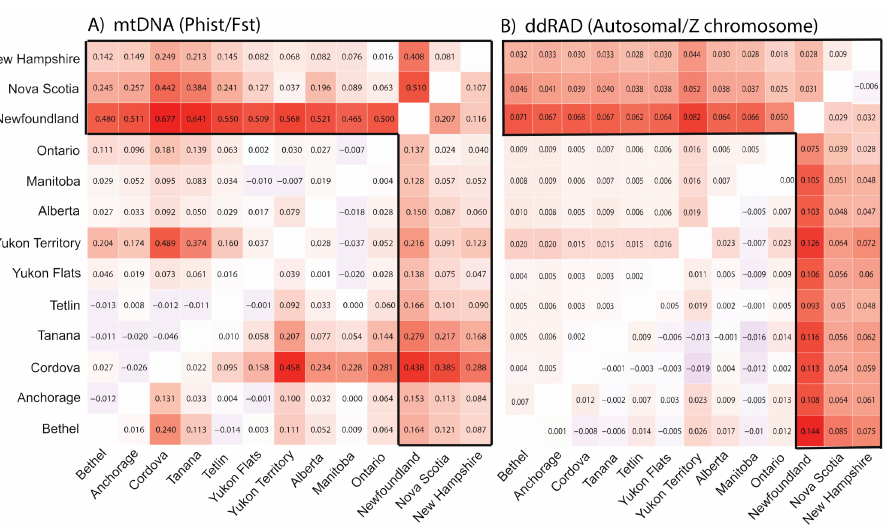
Figure 2. Pairwise Φ ST (above diagonal) and F ST (below diagonal) for mtDNA control region ( A ) and pairwise Φ ST estimate for 6205 autosomal loci (above diagonal) and 231 Z loci (below diagonal ( B ). Darker colors indicate higher values. The northeastern region where higher levels of genetic differentiation were found is